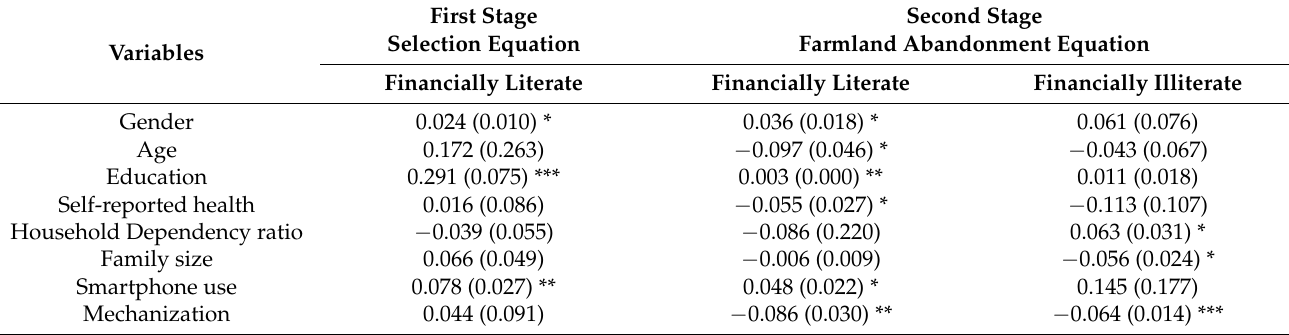
Table A2. Determinants of financial literacy and farmland